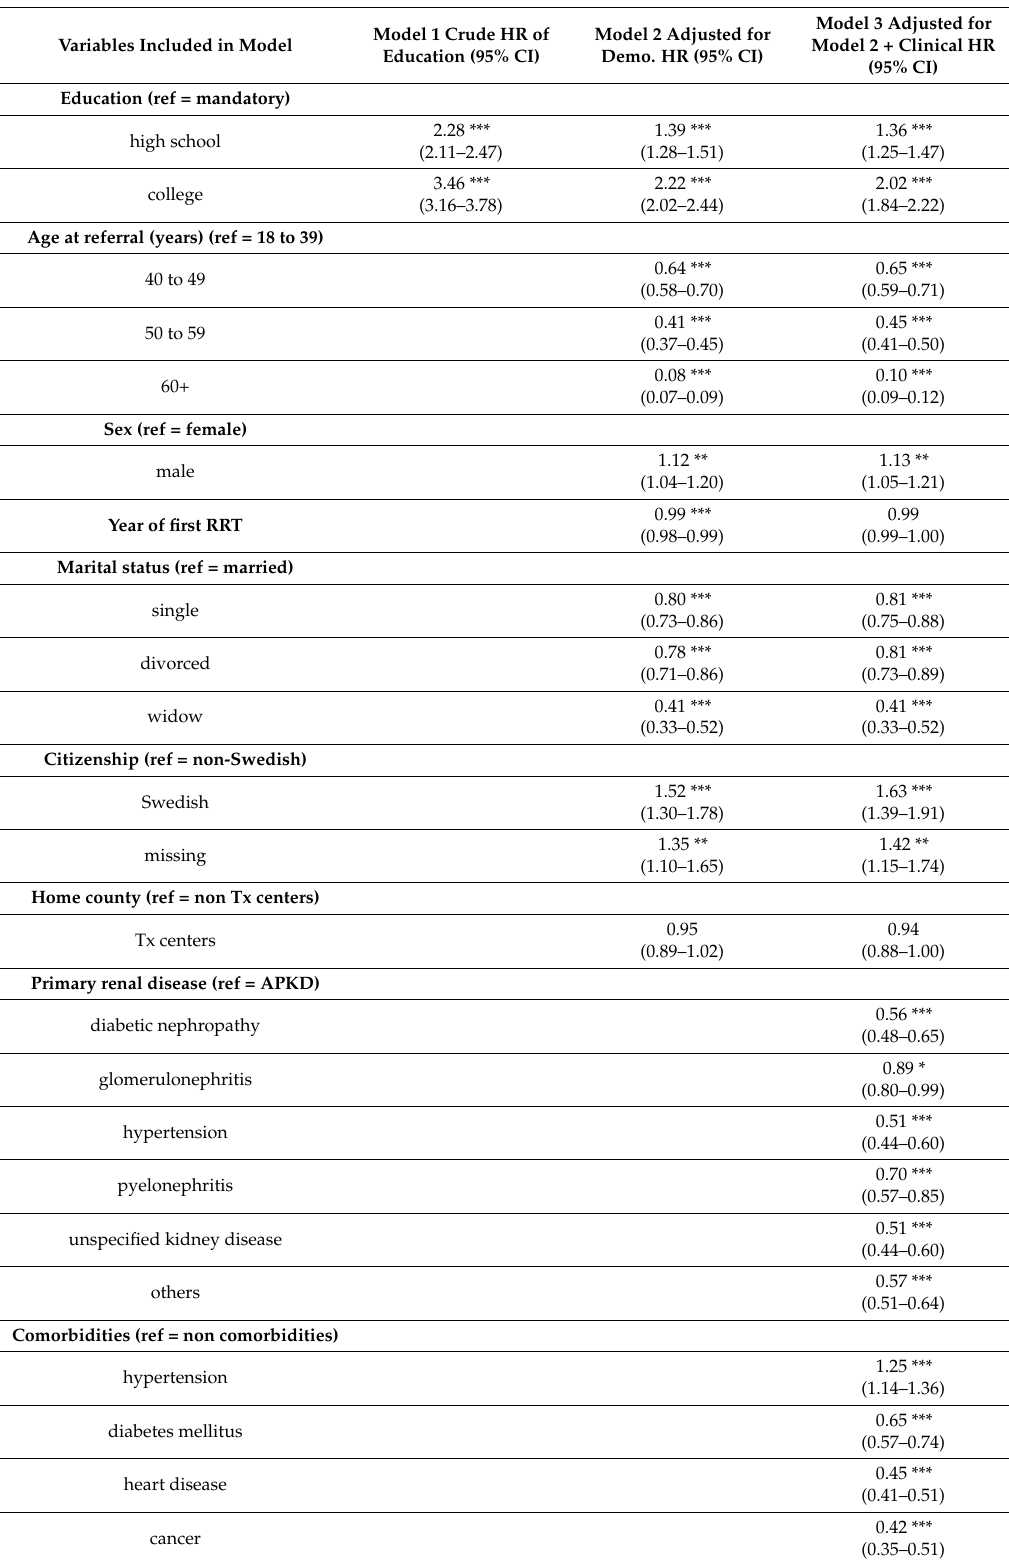
Model 1: Crude HR of education; Model 2: HRs were adjusted for demographic variables (age at referral, sex, year of first RRT, marital status, citizenship, and home county); Model 3: model 2 + clinical variables, which included primary renal disease and comorbidities. *** p < 0.001; ** p <0.01; * p <